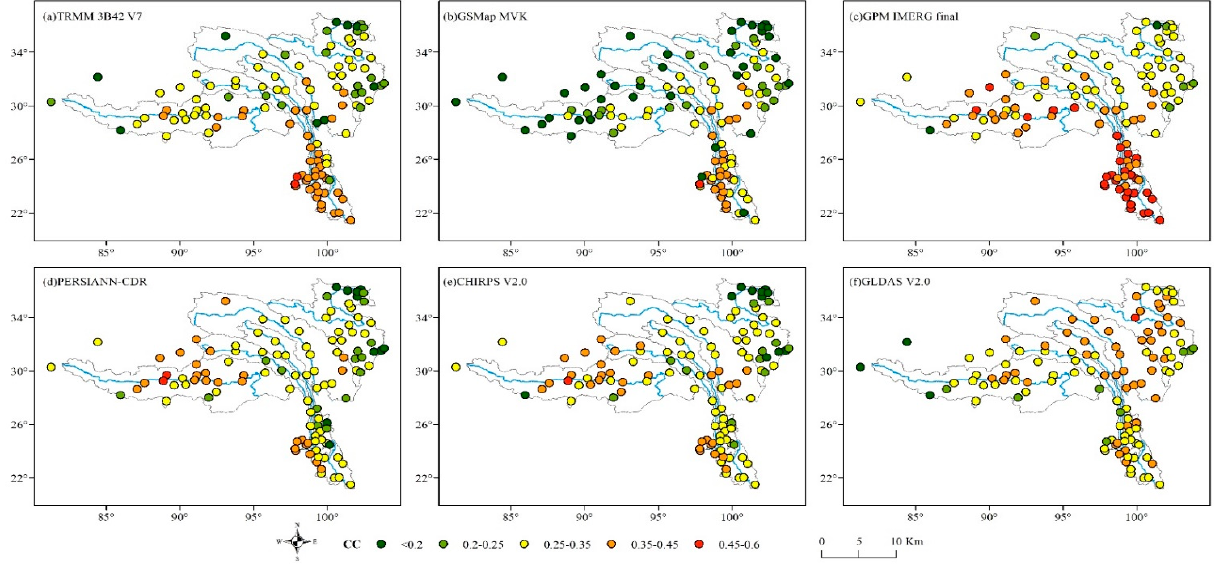
Figure 5. Correlation between different rain gauges and corresponding grids in data products.